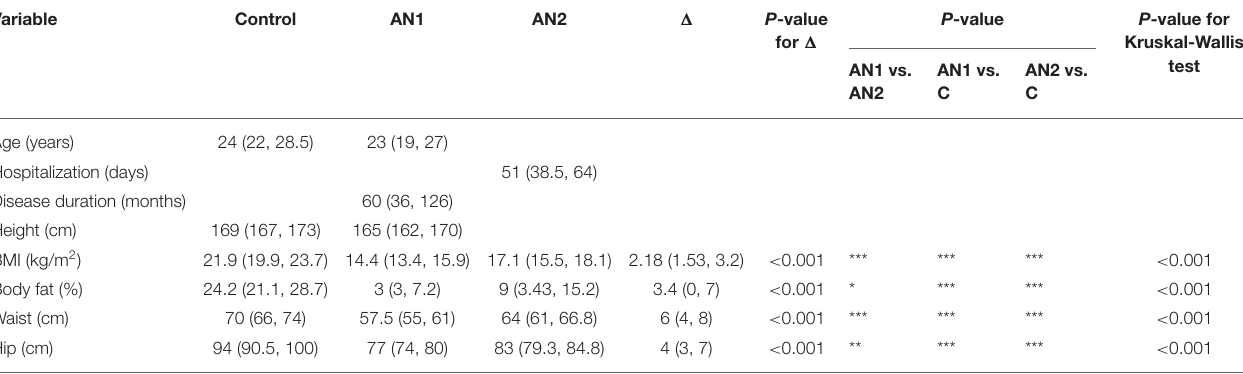
TABLE 1 | Comparison of anthropometric parameter values in healthy controls and patients with AN at the beginning (AN1) and at the end (AN2) of hospitalization. Variable